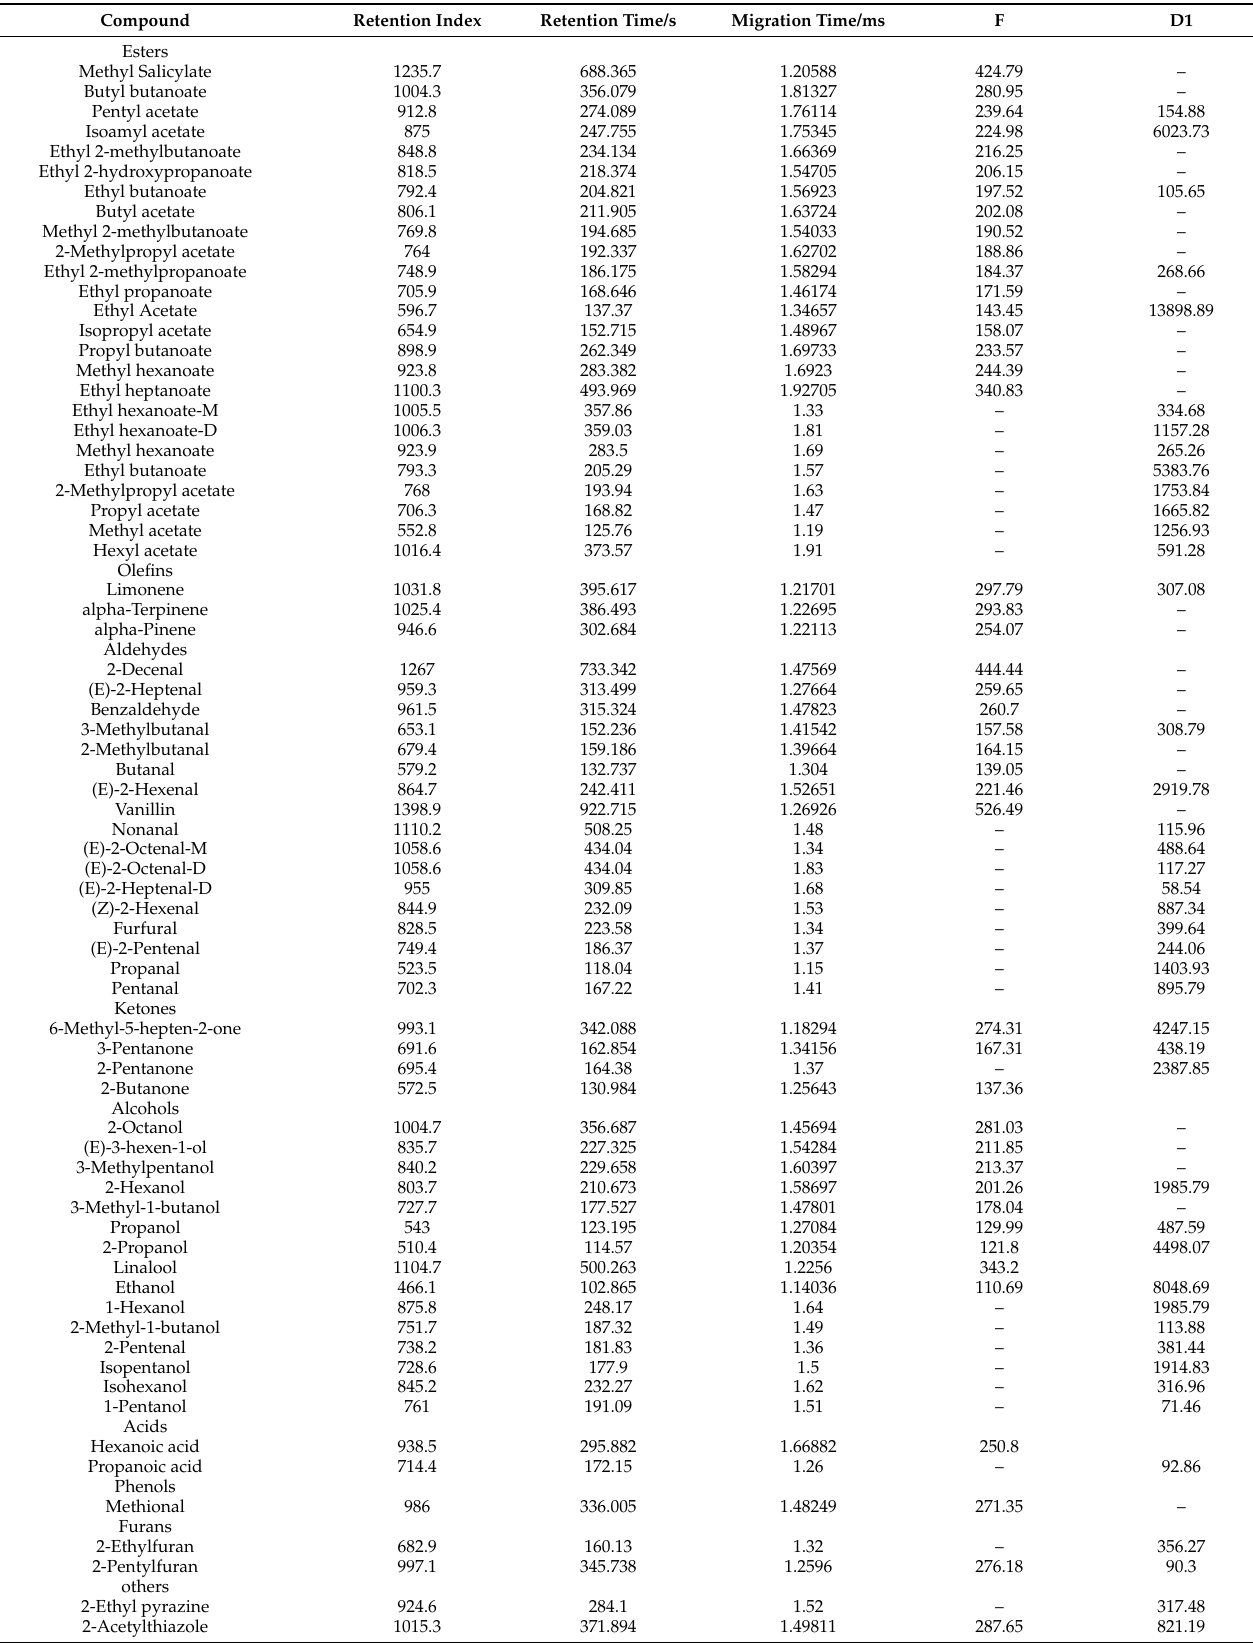
Table 3. Comparison of volatile